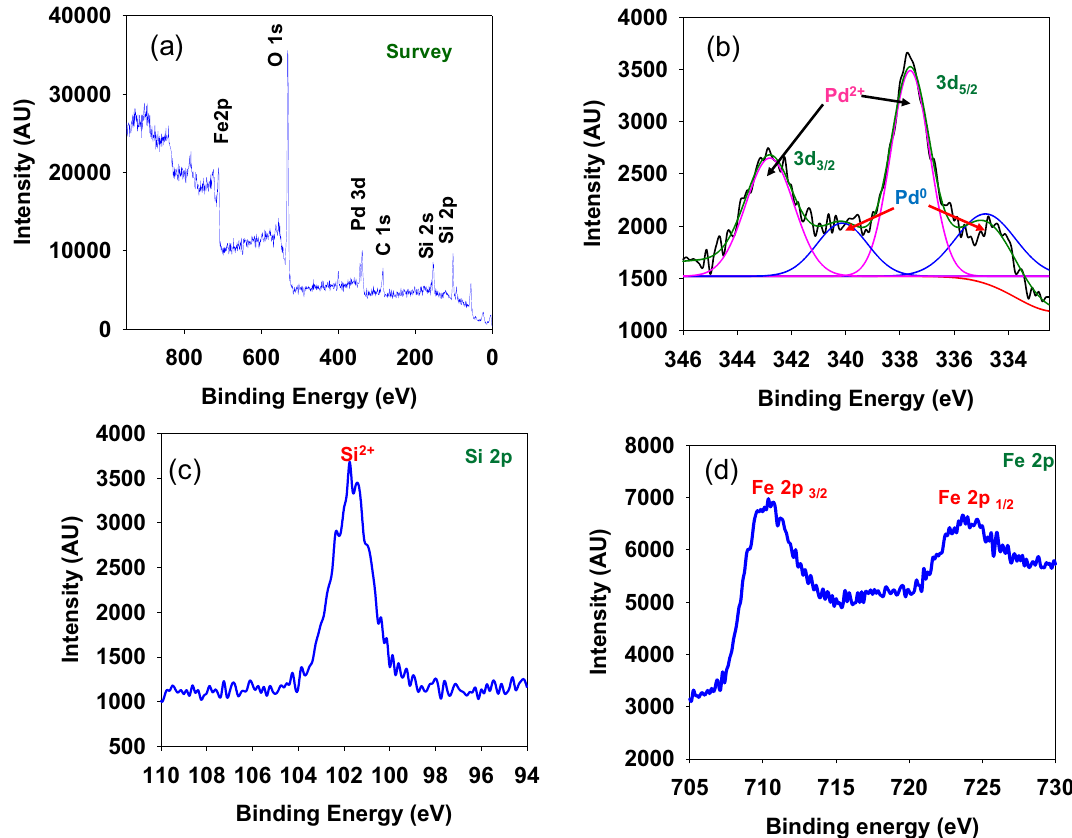
Figure 3. ( a ) XPS survey scan spectrum and high-resolution ( b ) Pd 3d 5 / 2 and 3d 3 / 2 , ( c ) Si 2p and ( d ) Fe 2p 3 / 2 of Fe 3 O 4 @SiO 2 /Pd 0 /Pd II NP ( 5 and 2p 1 2